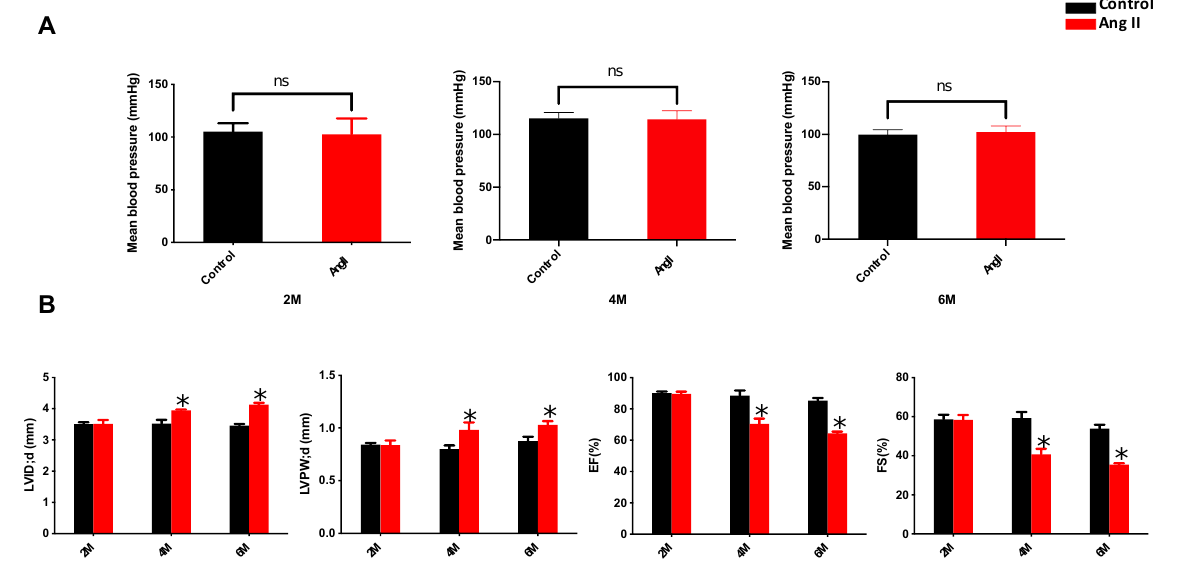
Figure 1. Ang II treatment induces cardiac remodeling and dysfunction in mice. Wild-type mice were injected subcutaneously with Ang II at a dose of 0.5 mg/kg every other day for 2 months and observed until 6 months. ( A ) The blood pressure of mice was measured by CODA Monitor non- invasive blood pressure monitoring system. ( B ) Cardiac function was detected by echocardiography in mice (LVID; d = Left ventricular end diastolic diameter; LVPW; d = Left ventricular end diastolic posterior wall thickness; FS = fractional shortening; EF = ejection fraction). Data are presented as the mean ± SD ( n = 7 – 9). * p < 0.05 vs. Control.